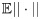
Signal-to-Noise Ratio (SNR) versus the expected normalized value of different norms (E||·||) to act as regularizers.A unregularized (left) and an regularized (right) Kernel Ridge Regression (KRR) model was fitted. The top row shows a few examples of these fitted KRR models with a different quantity of noise added. The red data points are the data with different noise levels, the true function is black and the fitted KRR model is in blue. The second row shows the norm for the different regularizers. All lines were normalized in such a way that they are comparable. The norm of the true signal (SNR = 50 dB) is subtracted from all points so any curve with values below zero require less regularization and any points above zero require more regularization.